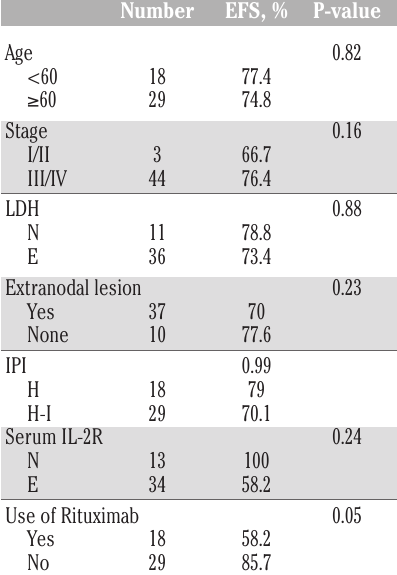
Table 3. Univariate analysis for 5-year event free survival in patients with autologous stem cell